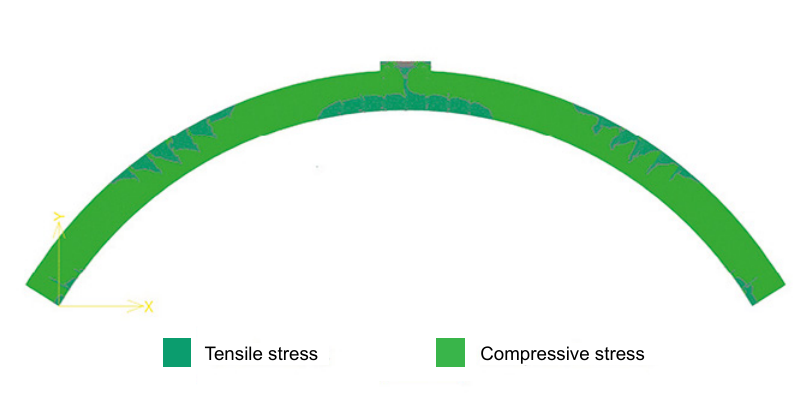
Figure 9. The distribution of principal stresses – the first series of vaults